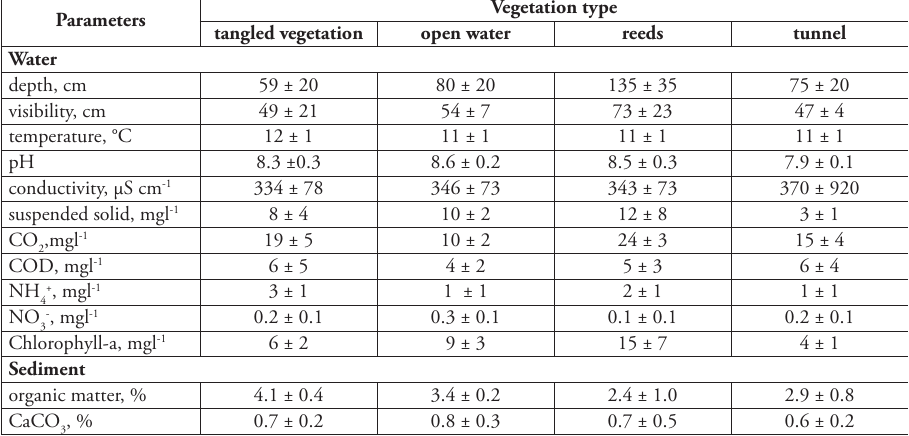
Correlation between sediment and water chemistry and Cladocera communities Based on the CCA ordination, our results show positive correlations between the or- ganic matter and the calcium carbonate content of sediment and A. elongatus , A. rec- tangular , L. leydigi and A.quadrangularis species (Fig. 5). In the cases of water chem- Table 2. Physical and chemical parameters of surface water and sediment (mean ± SD) according to vegetation